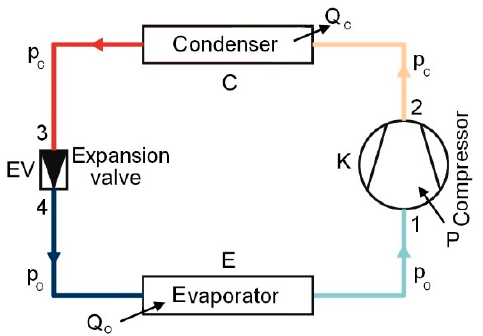
Figure 7. Scheme of a heat pump (HP) using vapour compression. A cycle of evaporation, compression, condensation, and expansion is required to